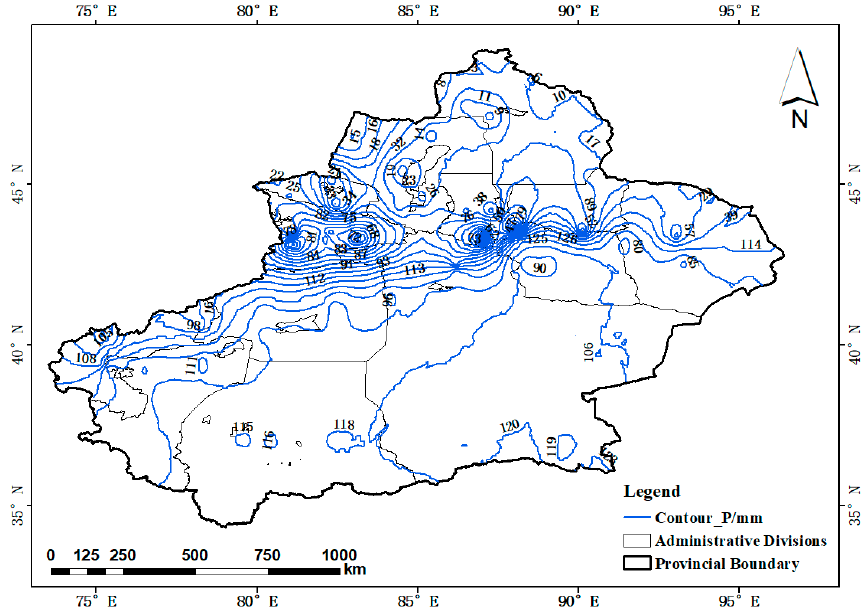
Figure 5. Spatial distribution of the precipitation in Xinjiang.